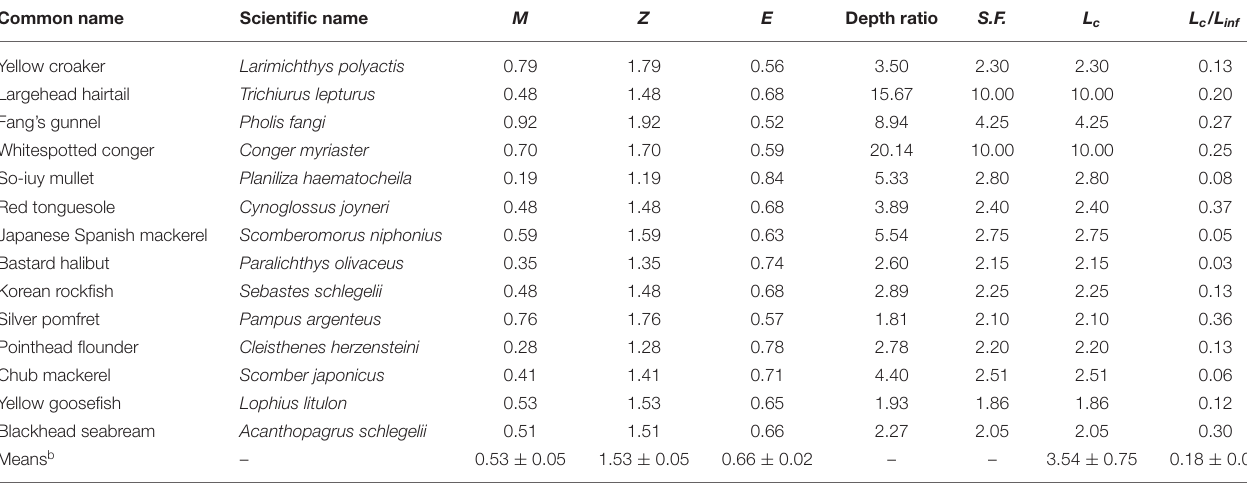
TABLE 4 | Estimates of mortality, mean length at first capture and derived parameters in 14 species of fish exploited along Chinese coasts ( M and Z in year − 1 ; L c in cm) a